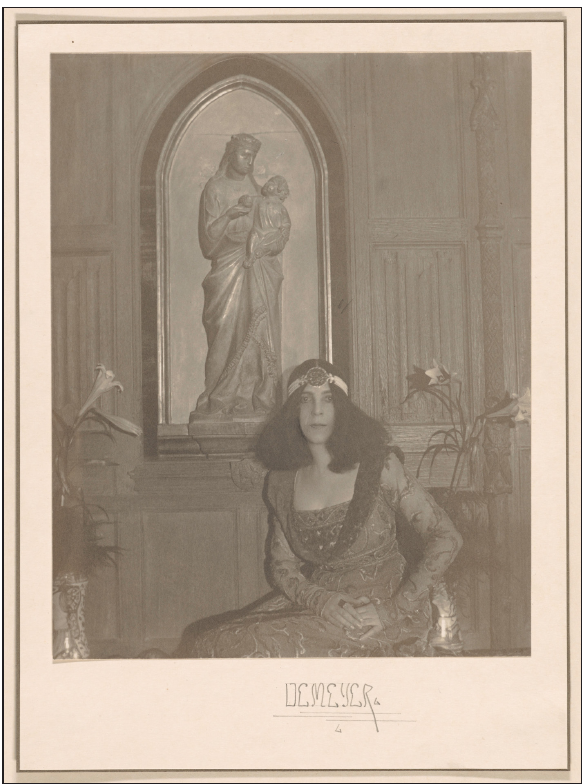
Fig. 9 : Adolf de Meyer, Florence Blumenthal in the library at 50 East 70th Street, c. 1920, platinum print, 24.1 × 19.4 cm, Metropolitan Museum of Art, New York. © The Metropolitan Museum of Art, New York/Art Resource,